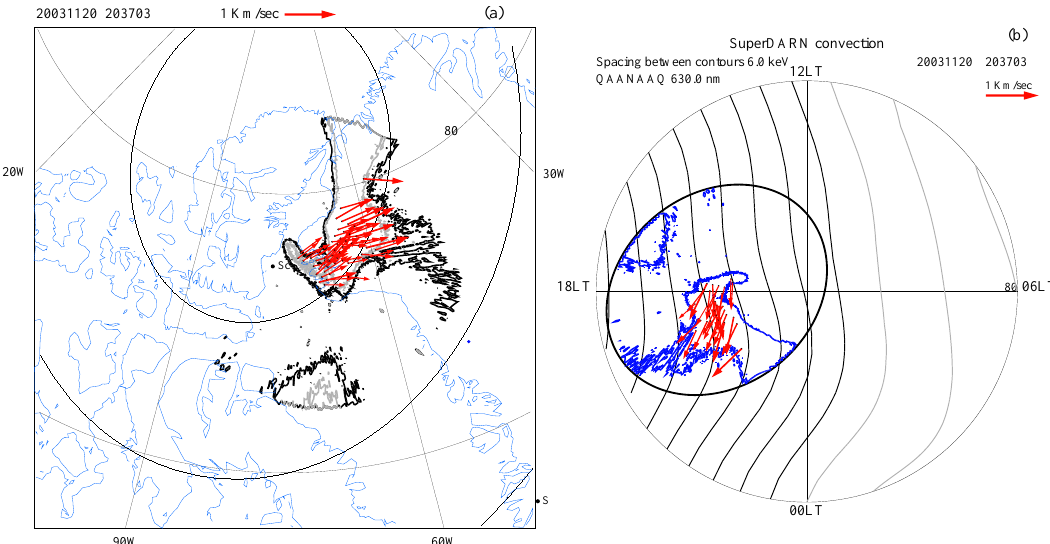
Figure 7. Airglow images (black and gray in left panel, and blue in the right panel) and vectors of the patch drift velocities (in red) plotted in a geographic frame (left panel) and CG polar plot (right panel). The oval shaped lines of (a) indicate the locations of CG latitudes equal to 86 and 82 ◦ , respectively. Notice the SuperDARN convection pattern corresponding to 2030UT is also included in (b) . Vectors were obtained by using a 2-D cross-correlation analysis that includes images for 20:35 and